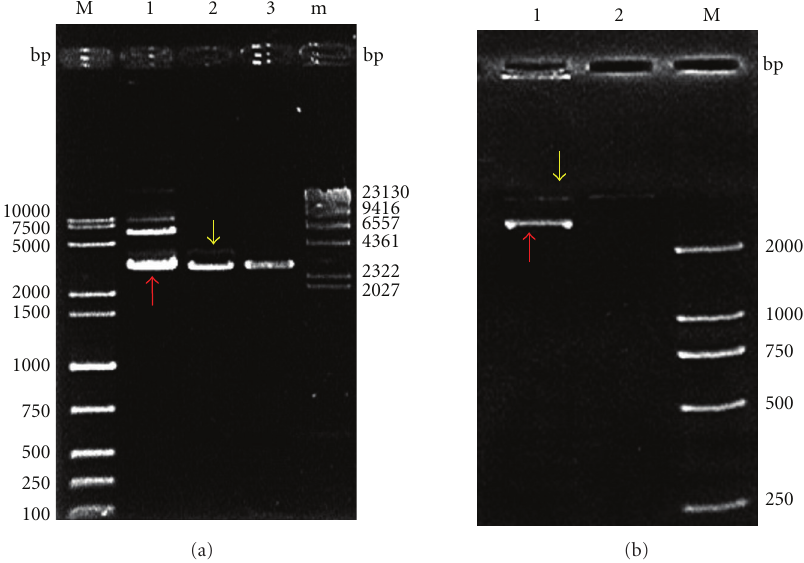
Figure 2: (a) The results of HIF-1 α -T vector double digestion with EcoR I and Sal I. 1–3: Clones 1–3; m: λ DNA/Hind III; M:DNA marker; Clones 1 and 2 were positive clone. Red arrow showed the HIF-1 α band, and yellow arrow showed the T vector band. (b) The results of HIF-1 α -pcDNA 3 . 1 vector double digestion with Hind III and BamH I. 2-1: HIF-1 α -pCDNA 3 . 1 positive clone; 2-2: pcDNA 3 . 1 empty vector; M: DL 2000. Red arrow showed the HIF-1 α band, and black arrow showed the pCDNA 3 . 1 vector